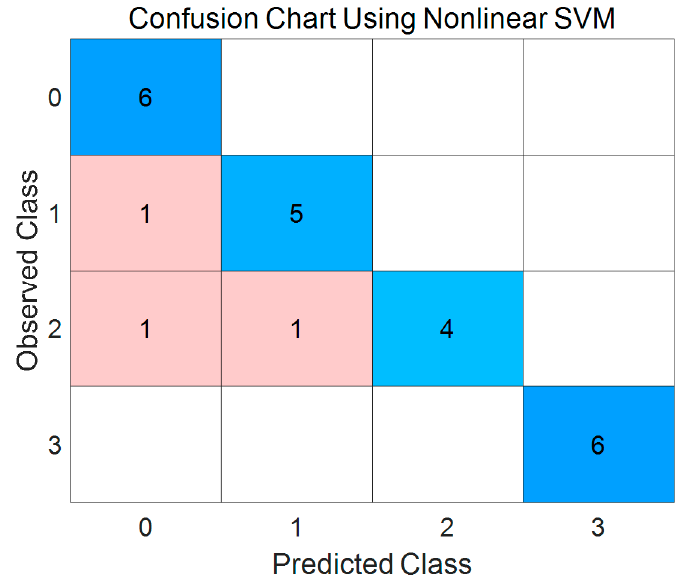
Figure 15. The confusion chart for the developed SVM